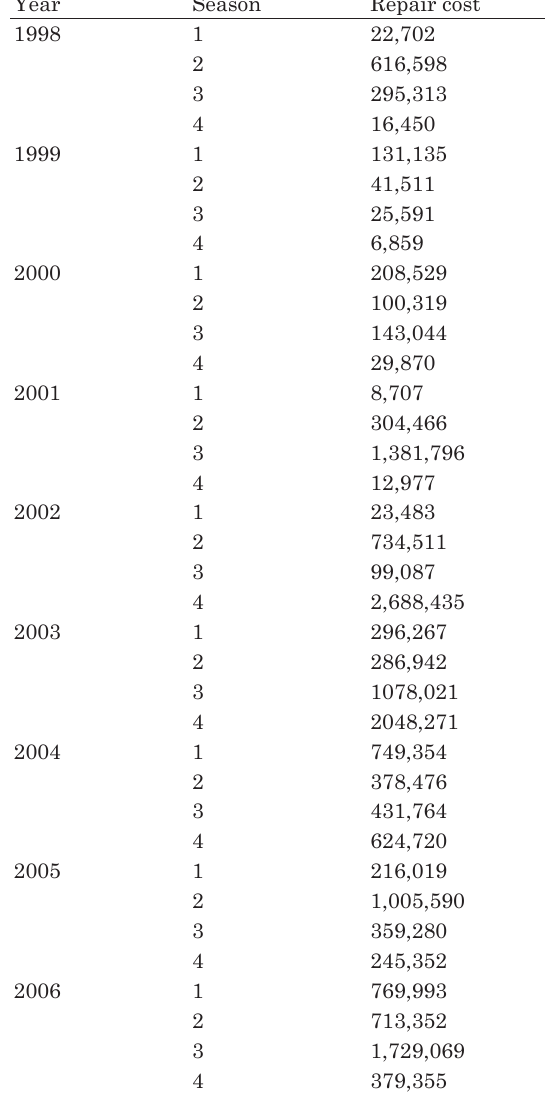
table 4. Quarterly repair cost of the east